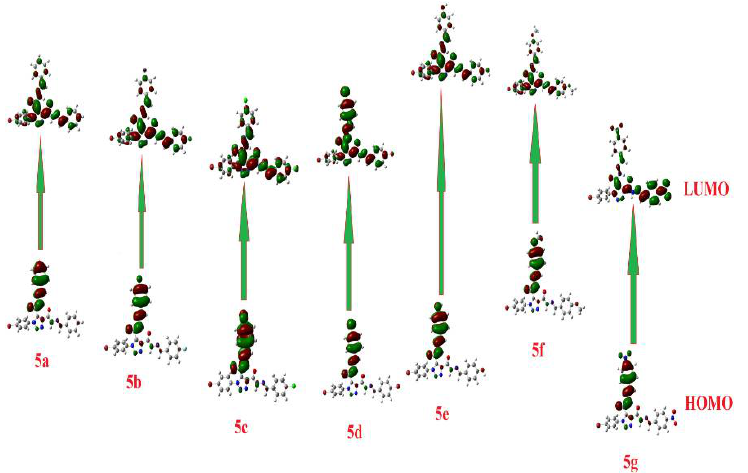
Figure 11. The calculated ground state isodensity surface plots for FMOs for the prepared com- pounds 5a – g